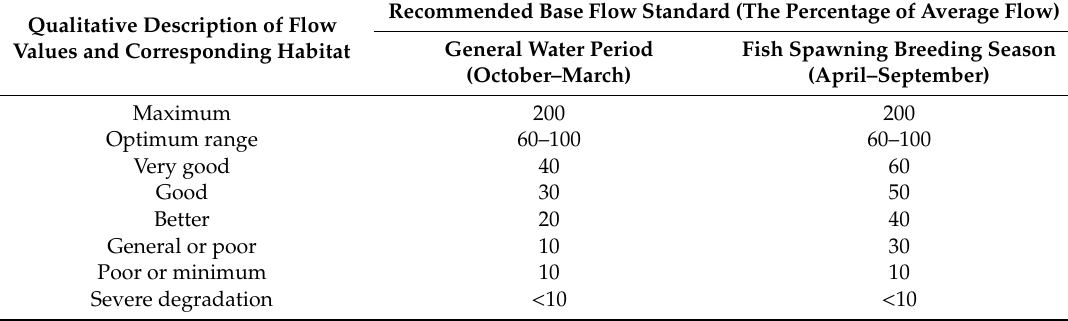
Table 1. Tennant method for the recommended base flow